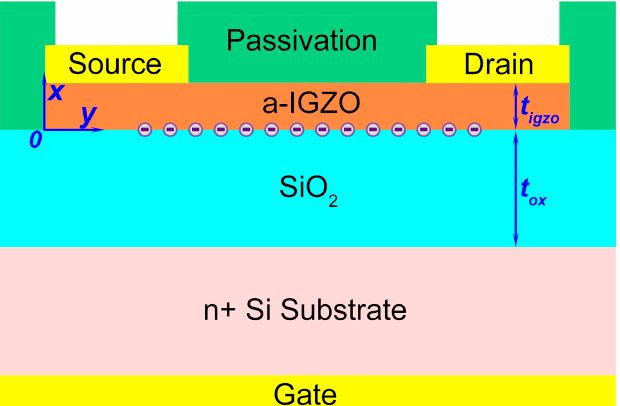
Figure 1. Schematic diagram of a-IGZO TFTs used in modeling.